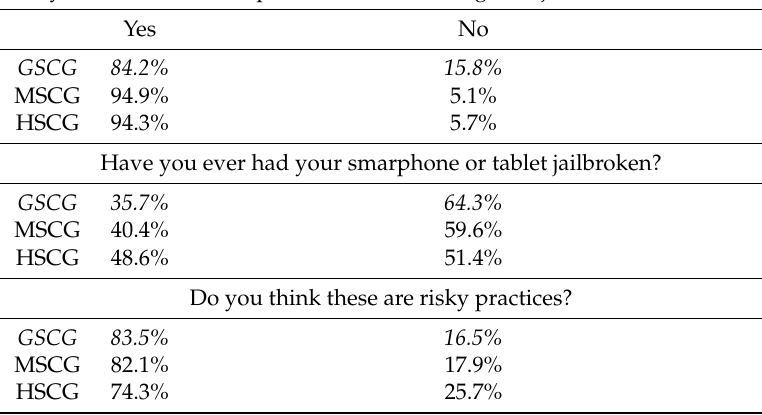
Table 8. Jailbreaking and rooting mobile